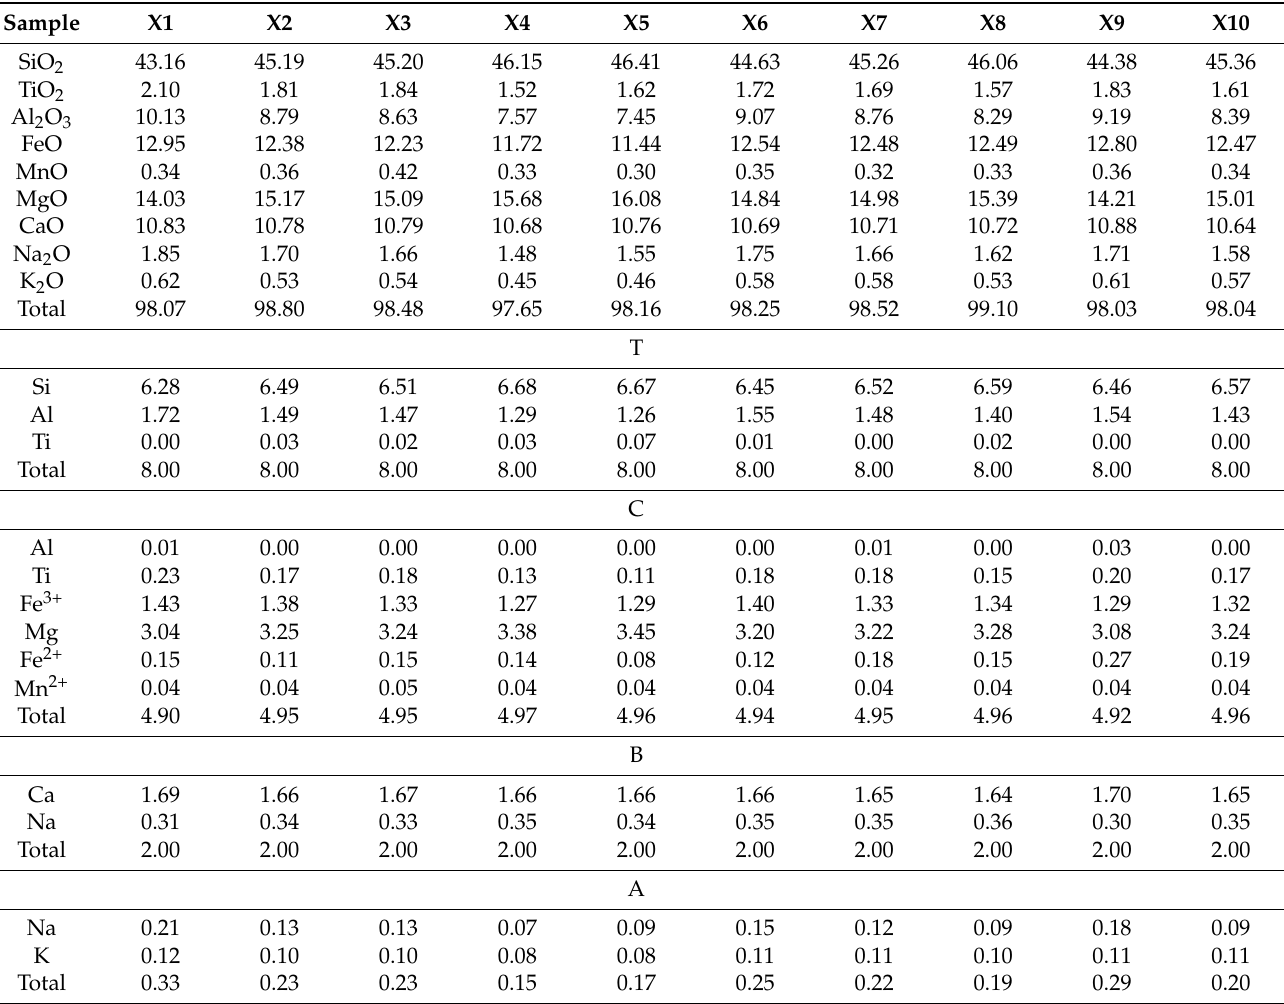
Table 3. Representative major-element compositions of amphibole from studied diorite